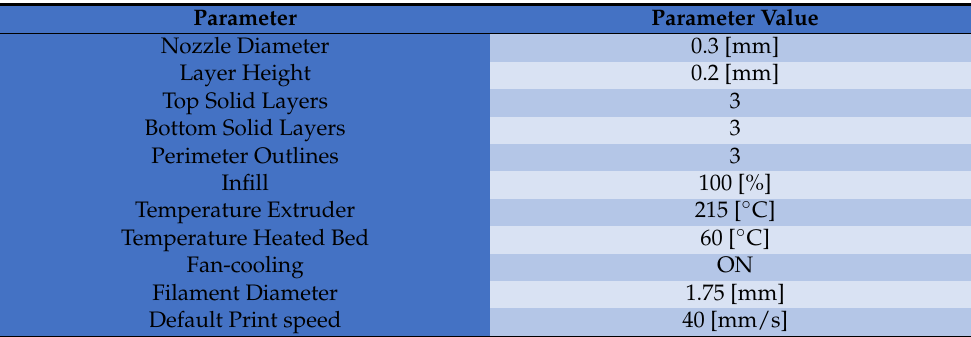
Table 1. Basic production parameters for production of tensile specimens.